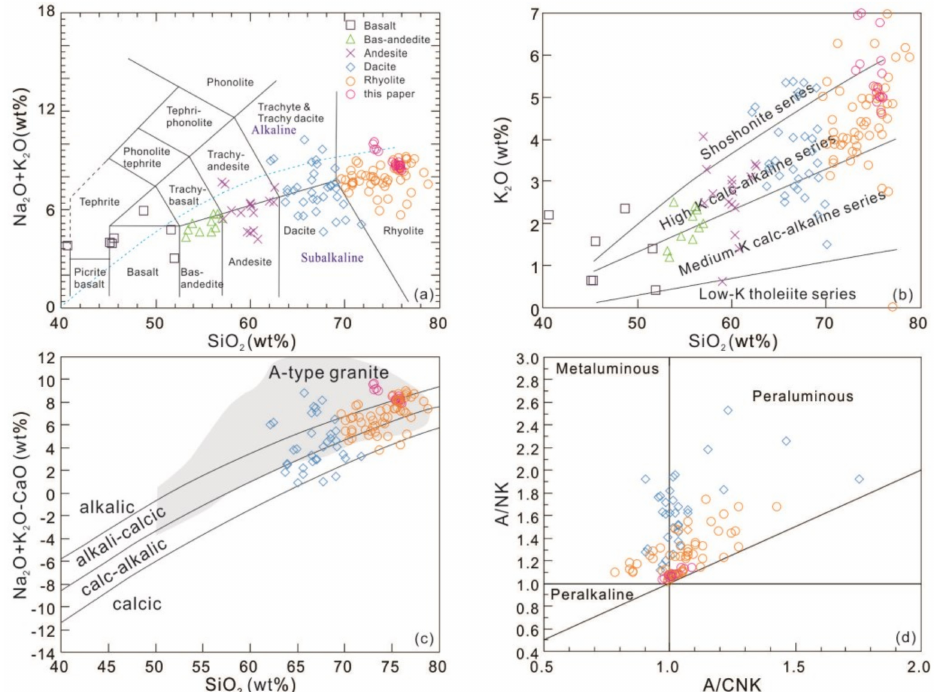
Figure 6. ( a ) TAS diagrams (after Middlemost [69]); ( b ) K 2 O vs. SiO 2 diagrams (after Rickwood [70]); ( c ) (Na 2 O + K 2 O − CaO) vs. SiO 2 diagrams (after Frost et al. [71]); ( d ) A/NK vs. A/CNK diagrams (after Maniar et al. [72]) for the Keri rhyolites in the EKOB. Geochemical data of Elashan Formation volcanics from references